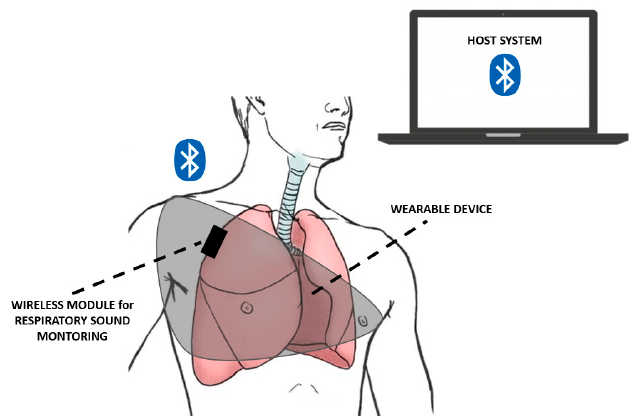
Figure 12. Schematics of a wearable and wireless breathing sound monitoring system as presented in [108].